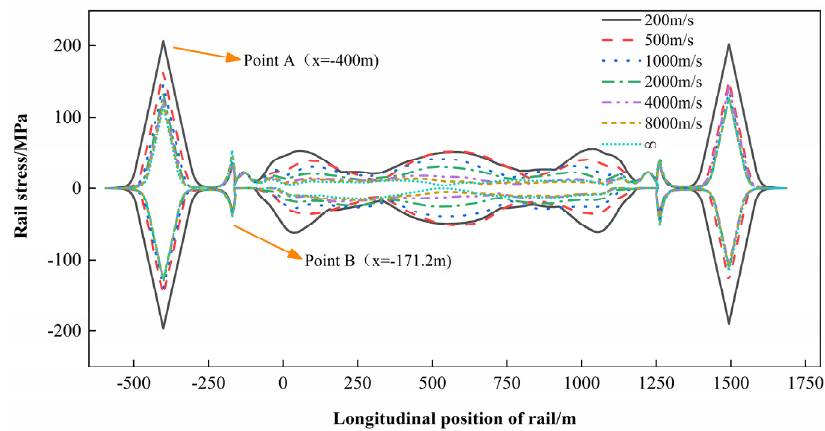
Table 4. Rail stress at different apparent wave velocities.